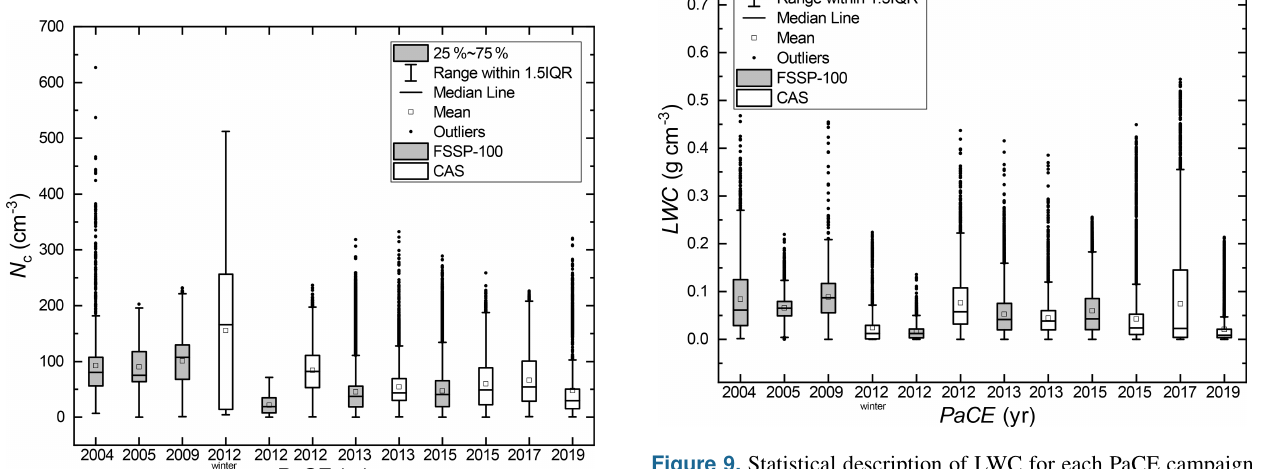
Figure 9. Statistical description of LWC for each PaCE campaign when the FSSP-100 and CAS ground setups were